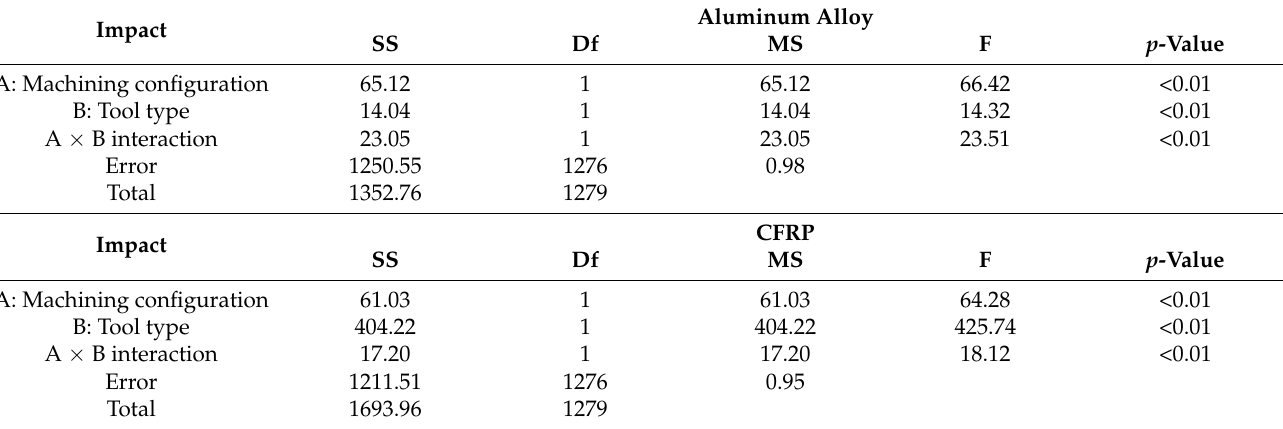
Table 4. Two-factor analysis of variance for Rz surface roughness parameter depending on the machining configuration and the type of